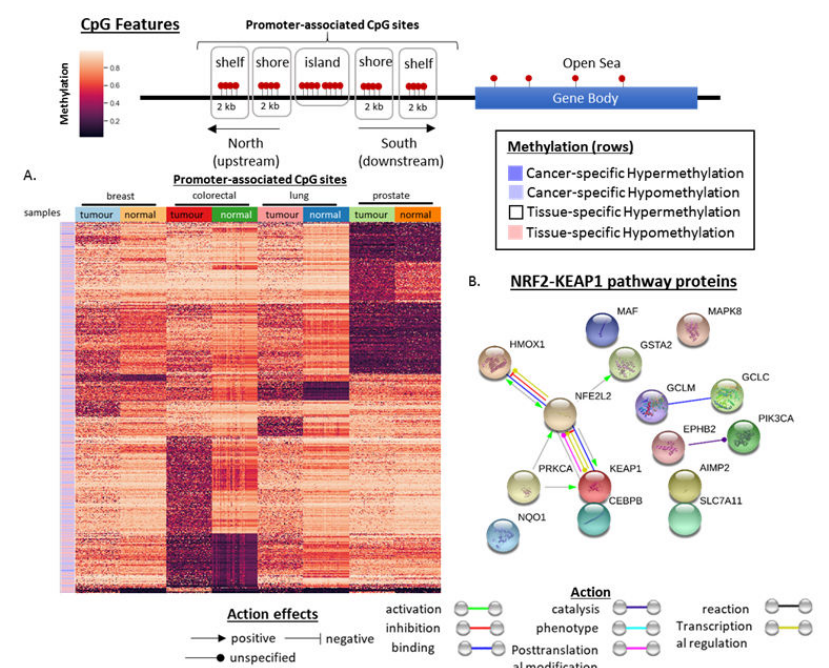
Figure 8. Visualization of MethylMine-filtered methylation biomarkers that overlap with the NRF2-KEAP1 and PIK3 pathway. ( A ) Visualization of di ff erentially methylated CpG sites within the promoter associated CpG sites. CpG sites corresponding to di ff erent types of methylation are in the rows, while samples from either tumor or normal tissue of the four analyzed cancers are in the columns. ( B ) Protein-protein network analysis of filtered proteins from the MethylMine pipeline-filtered probes that found 15 corresponding genes that are associated with the NRF2-KEAP1 and PIK3 pathway. The mode of action between each protein (node) is described by the di ff erent colors of the lines, while the e ff ects of the action are summarized by the direction of the arrow or